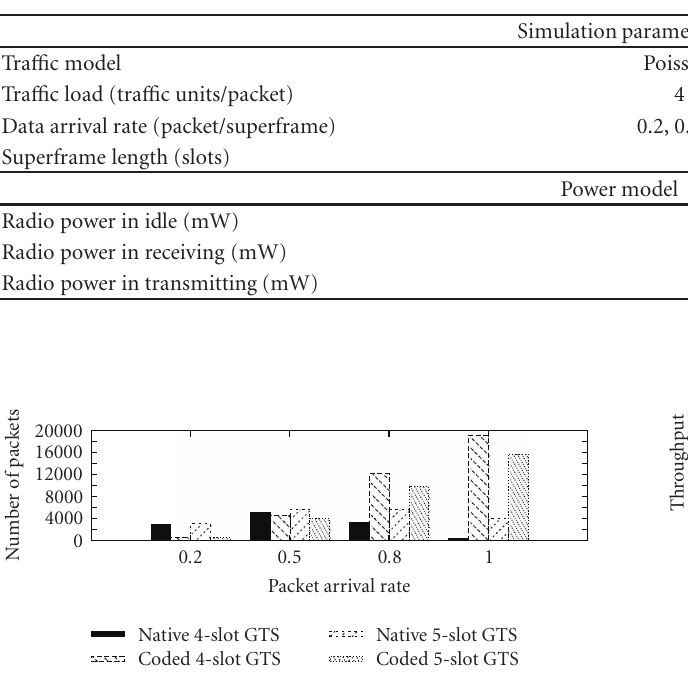
Figure 5: The number of packets directly relayed or XORed under di ff erent data rates.